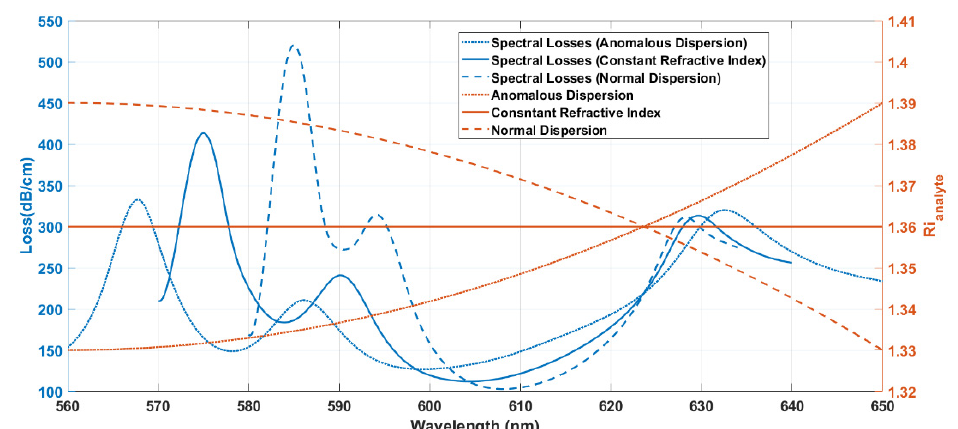
Figure 3. Dispersion profiles and related spectral losses of the SPR D-shaped PCF with three gold slabs. Solid lines represent the case of a constant refractive index of 1.36 and corresponding spectral losses. The second-order anomalous and normal dispersion regimes are expressed by Ri analyte = 7.41 × 10 − 6 λ 2 − 0.0083 λ + 3.65 and Ri analyte = − 7.41 × 10 − 6 λ 2 + 0.0083 λ − 0.93, respectively. Their related spectral losses are represented by dotted lines and dashed lines,